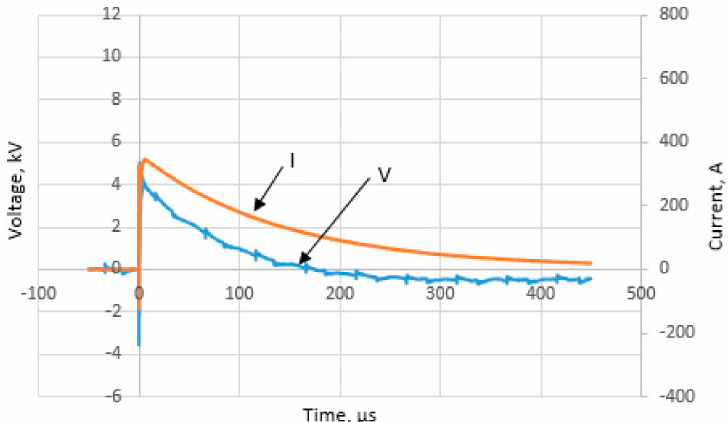
Figure 5. Voltage and current traces of positive polarity for electrodes installed at site 1 at a charging voltage of 30